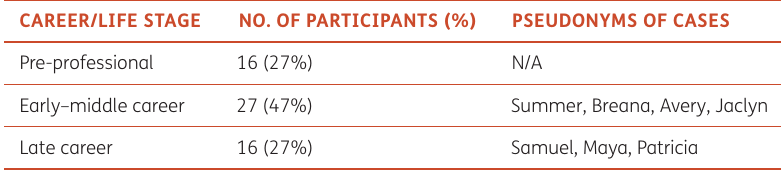
Table 1 Career and life stages of 59 case study community